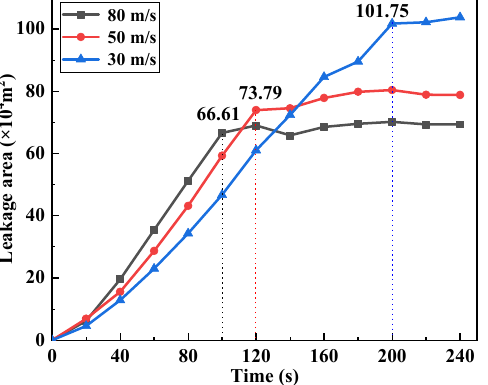
Figure 4. Trend of the crude oil leakage area at different leak velocities.